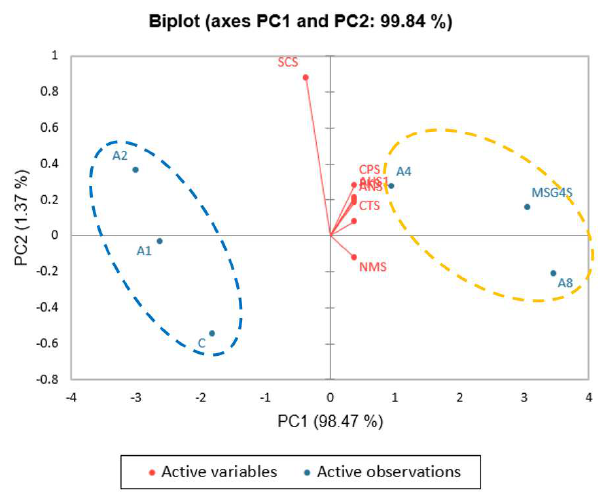
Figure 7. PCA biplot of standard soups with varying concentrations of SGM, standard soup with 0.4% MSG, and control standard soup. Differences among samples were identified using cluster analysis, and groups are represented by blue and yellow ovals ( p < 0.05). C: Control standard soup sample, A1: 0.1% SGM standard soup, A2: 0.2% SGM standard soup, A4: 0.4% SGM standard soup, A8: 0.8% SGM standard soup, and MSG4S: 0.4% MSG standard